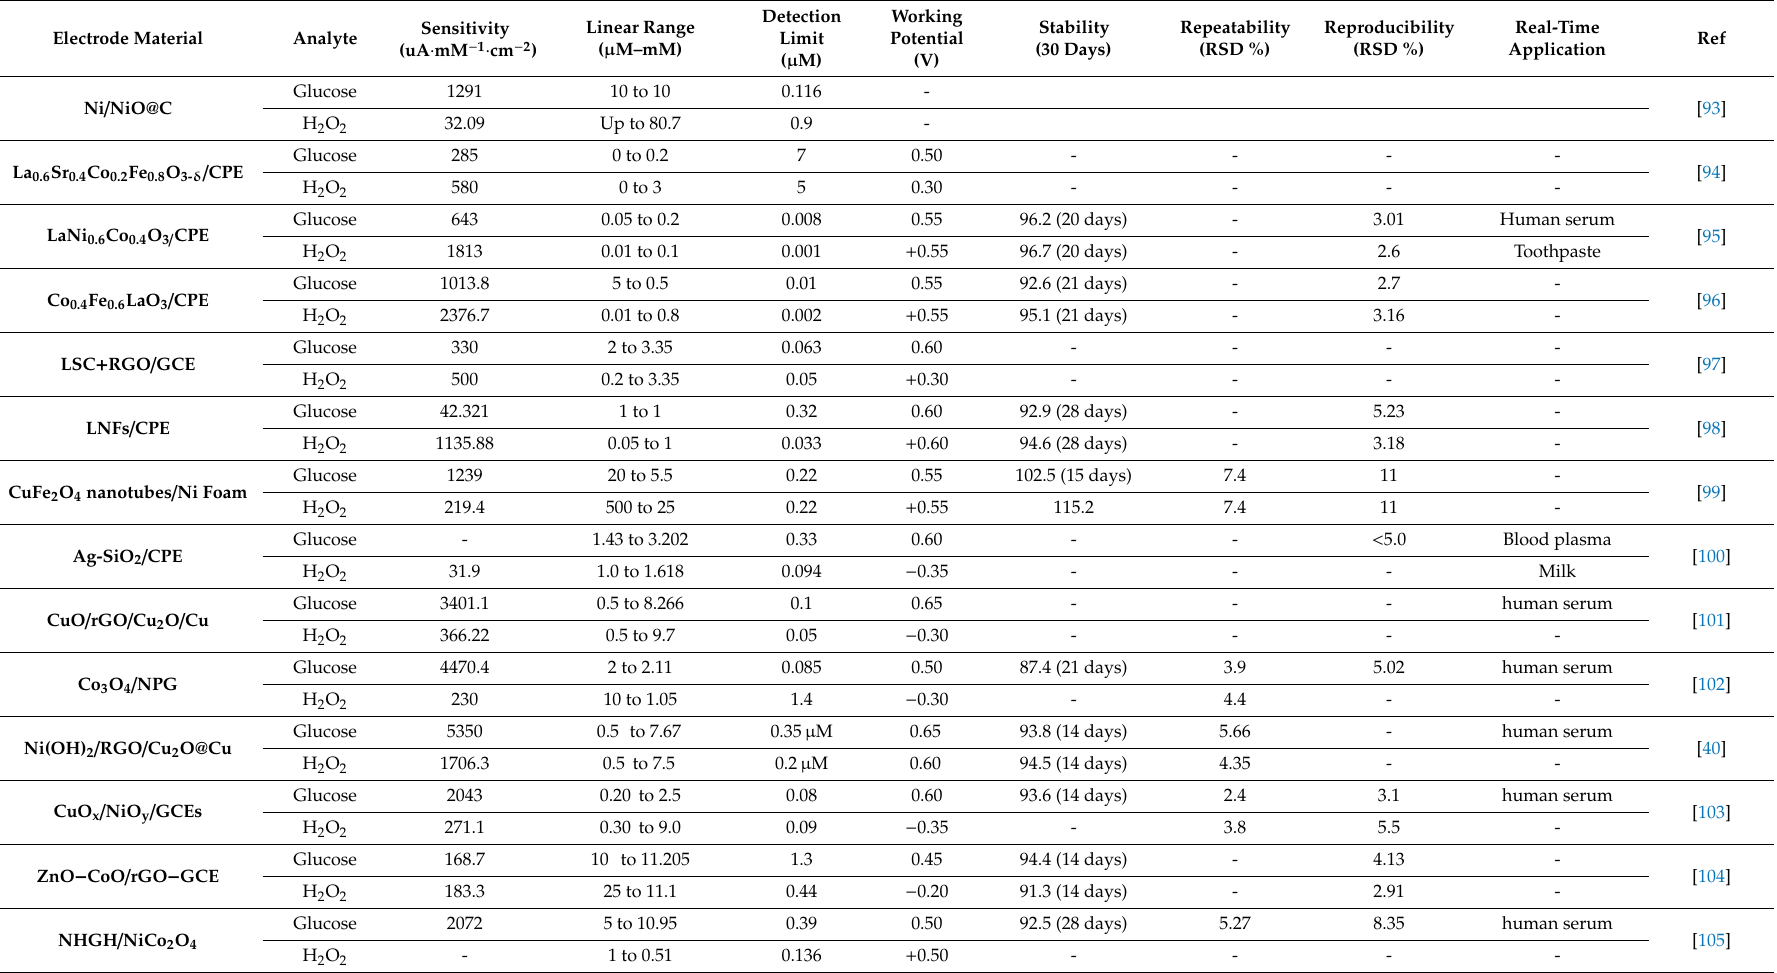
Table 4. Sensing parameters of non-enzymatic glucose and H 2 O 2 electrochemical sensors based on metal / metal oxide nanocomposites. Electrode